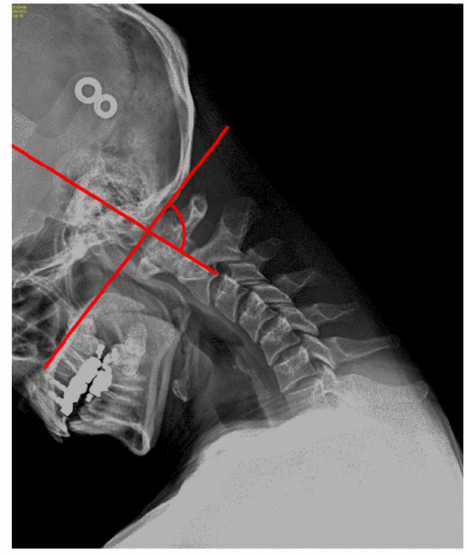
Figure 2. Measurement of upper cervical flexion angle using X-ray.